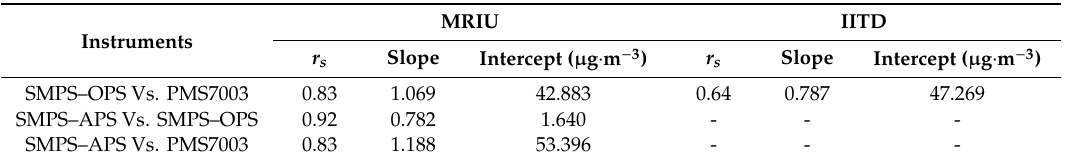
Table 1. Observed parameters for di ff erent pairwise Spearman’s rank-order correlation among sampled datasets using various PM 10 measuring instruments at two